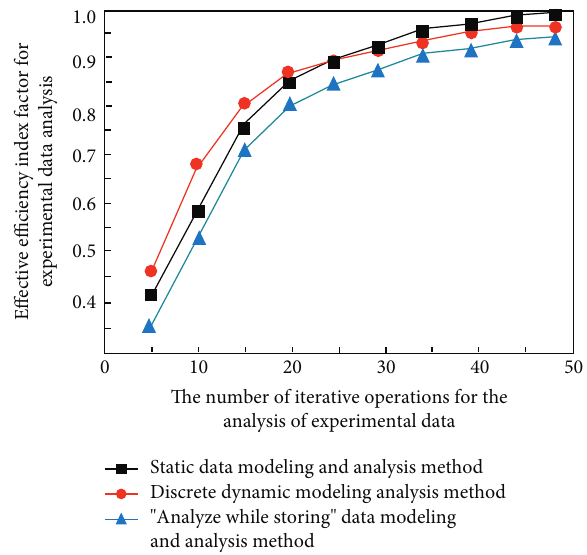
Figure 9: The relationship between the number of iterative cal- culations of experimental data analysis and game